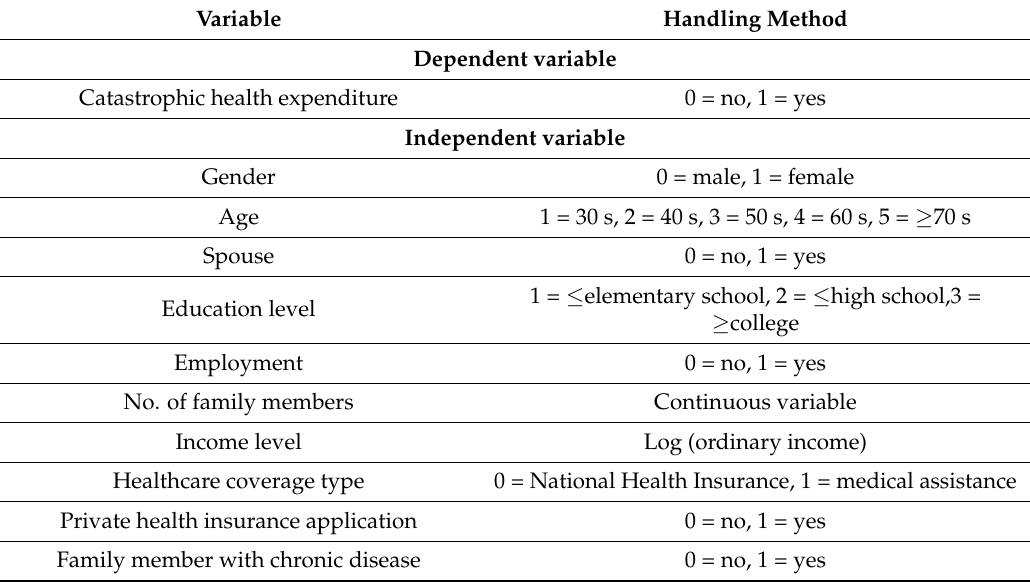
Table 1. Variable selection and handling